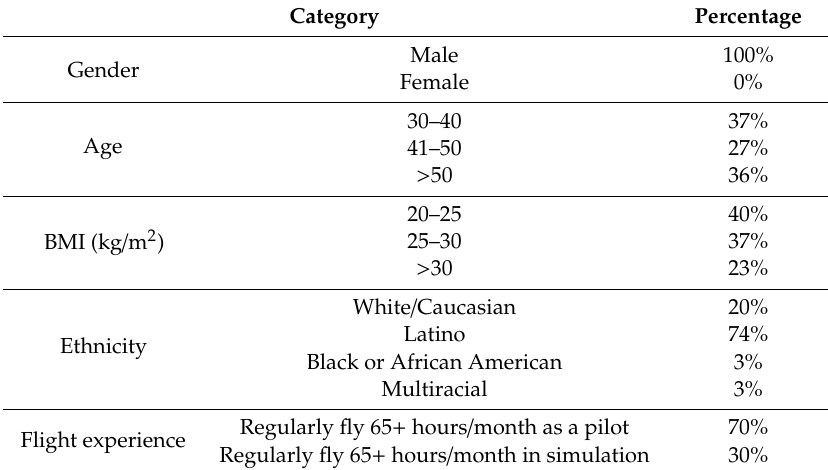
Table 1. Basic information of participating